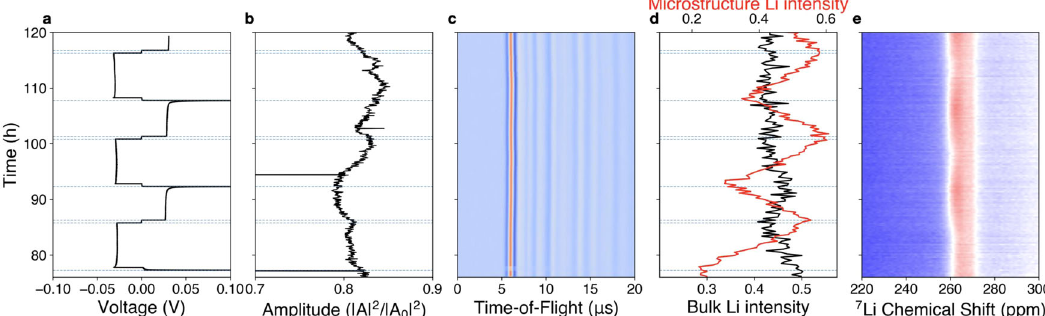
Fig. 6 Synchronized operando acoustic transmission and ssNMR spectroscopy. Lithium plating and stripping through LLZO at a current rate of 0.05 mA/ cm 2 in a Li/LLZO/Cu cell 43 , indicating microstructure formation during plating on copper and irreversible microstructure formation over three cycles. ssNMR and acoustic transmission are conducted simultaneously, as shown by the schematic in Fig. 1b. a Voltage (V vs Li + /Li) pro fi le, b acoustic transmission amplitude (arbitrary units), c acoustic time-of- fl ight ( μ s) of the entire waveform, d ssNMR normalized peak intensities, e 7 Li chemical shift (ppm) of the lithium metal